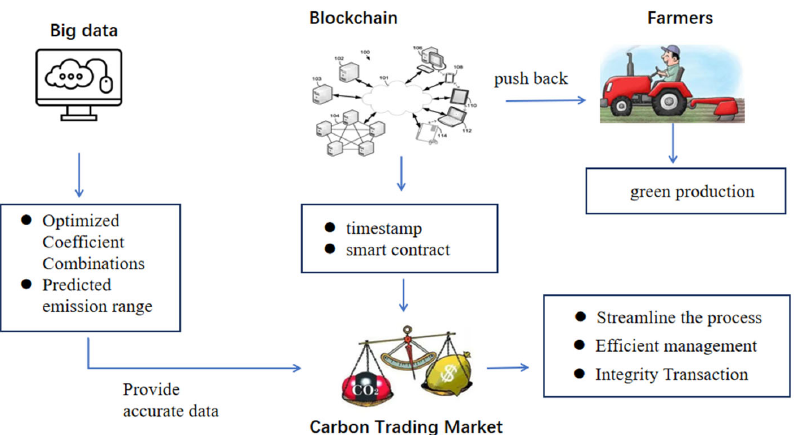
Figure 3. How big data and blockchain technology help reducing agricultural carbon emissions.